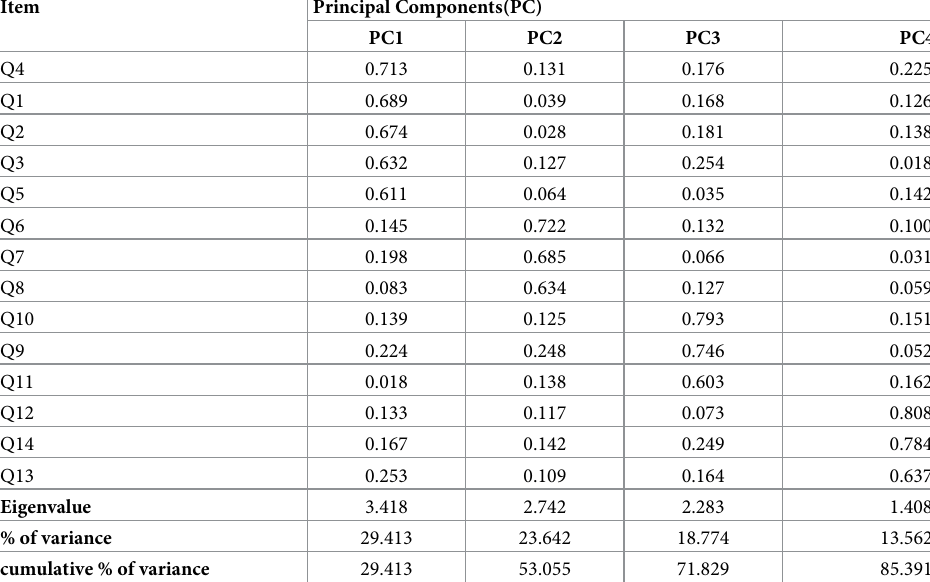
Table 4. Path coefficients of the structural